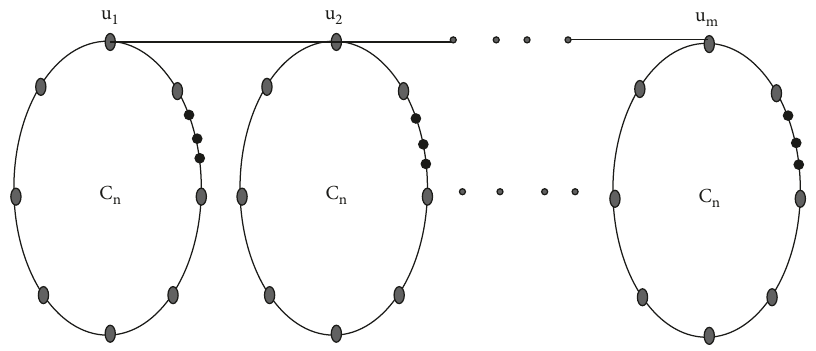
Figure 2: Bridge graph over cycle C